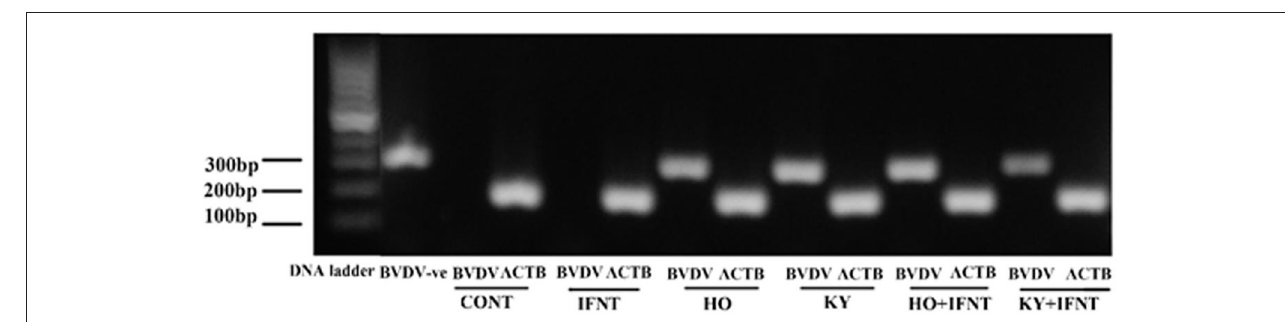
FIGURE 2 | PCR validation demonstrating infection of primary cultures of mixed bovine endometrial cells (epithelium plus stroma) with either Ho916 (HO) or KY1203 (KY) strains of ncpBVDV-1. Cells were cultured for 4 days before inoculation with each BVDV strain at a multiplicity of infection (MOI) of 0.1. After a further 4 days, half the cultures were then stimulated with 100ng/mL IFNT and the cultures were terminated 24h later. The expected product sizes for BVDV and the β -actin gene (ACTB) are 288 and 182 bp, respectively. The first two lanes contain BVDV-positive and negative controls.